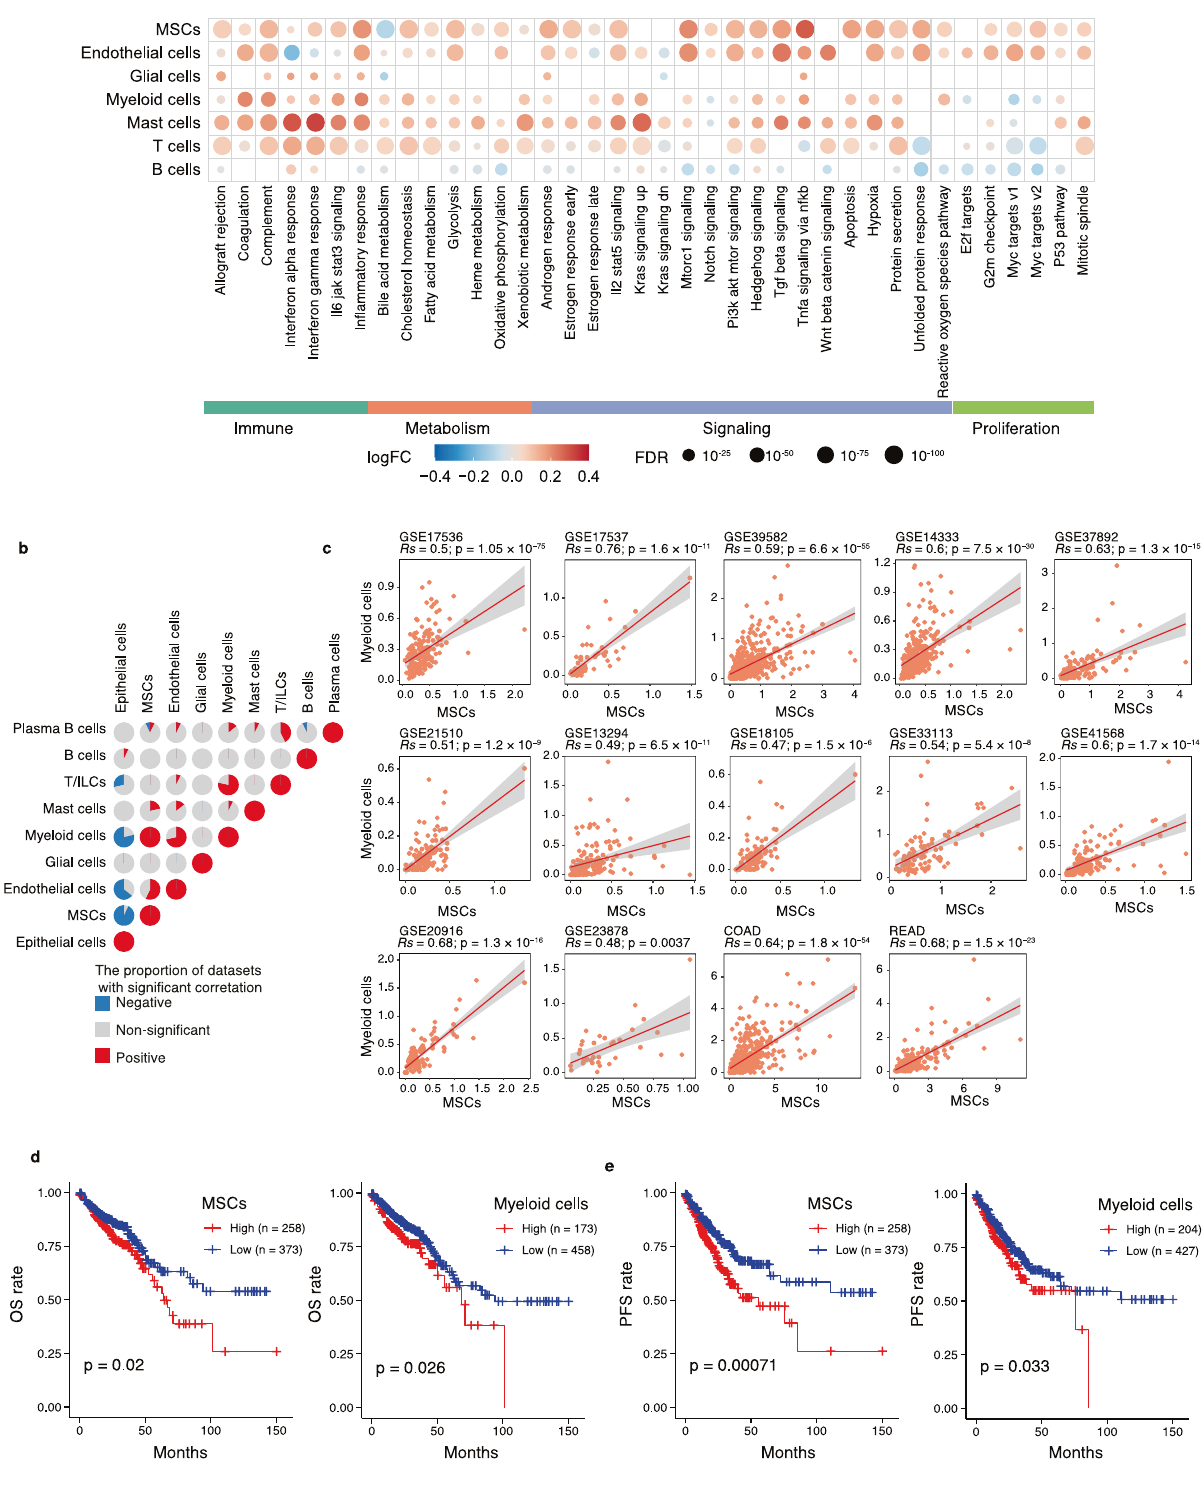
than those of normal samples (Fig. 2a). These characteristics might re fl ect a stromal cell interaction localized in the hypoxic region of the tumor that links macrophages, MSCs, and ECs to remodel the CRC microenvironment. In addition, tumor- in fi ltrating myeloid cells and T/ILC exhibited greater